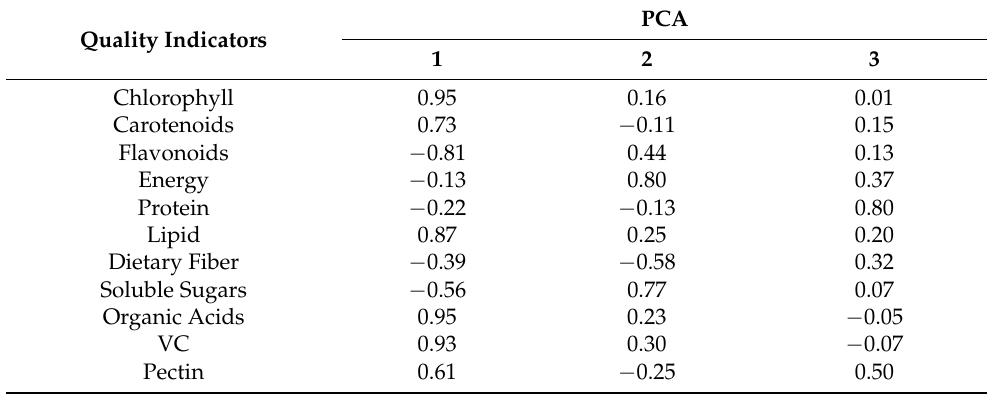
Table 3. The component matrix after the principal component is rotated on each quality